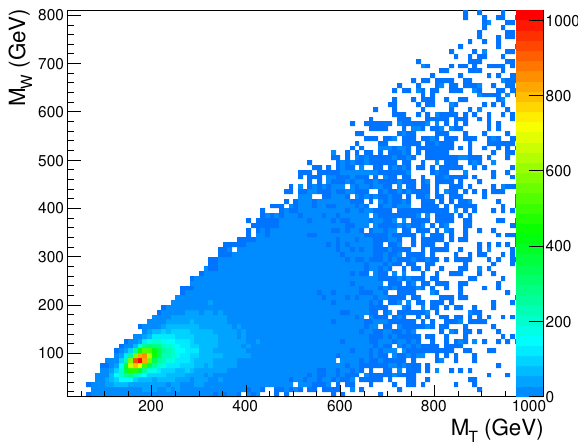
Figure 4 . Reconstructed M T and M W per event for a sample of signal (top-pairs) and background events corresponding to an intergrated luminosity of 50 fb − 1 at 13